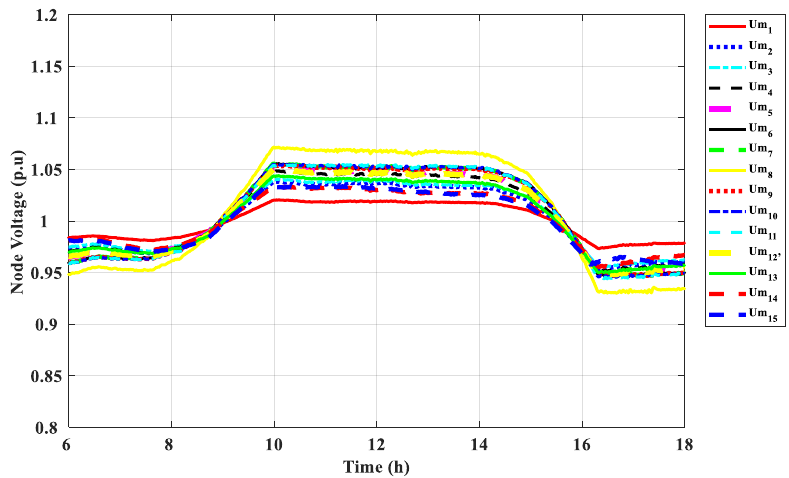
Figure 14. The voltage situation with distributed control when agent 8 malfunctions.